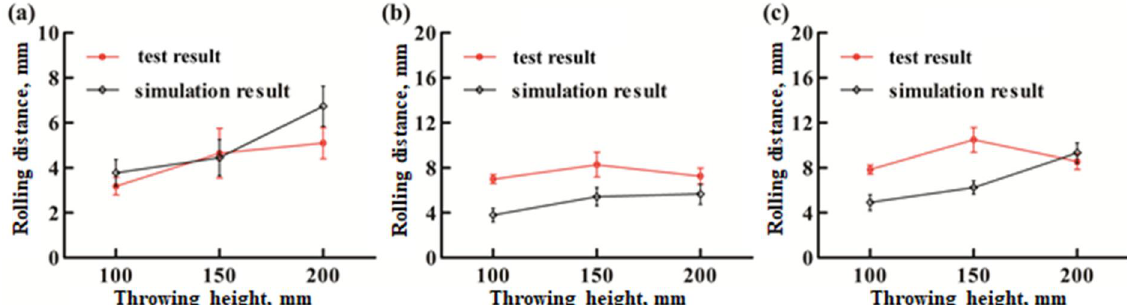
Figure 10. The relationship between rolling distance and throwing height for ( a ) SN42, ( b ) JD17 and ( c ) ZD39.